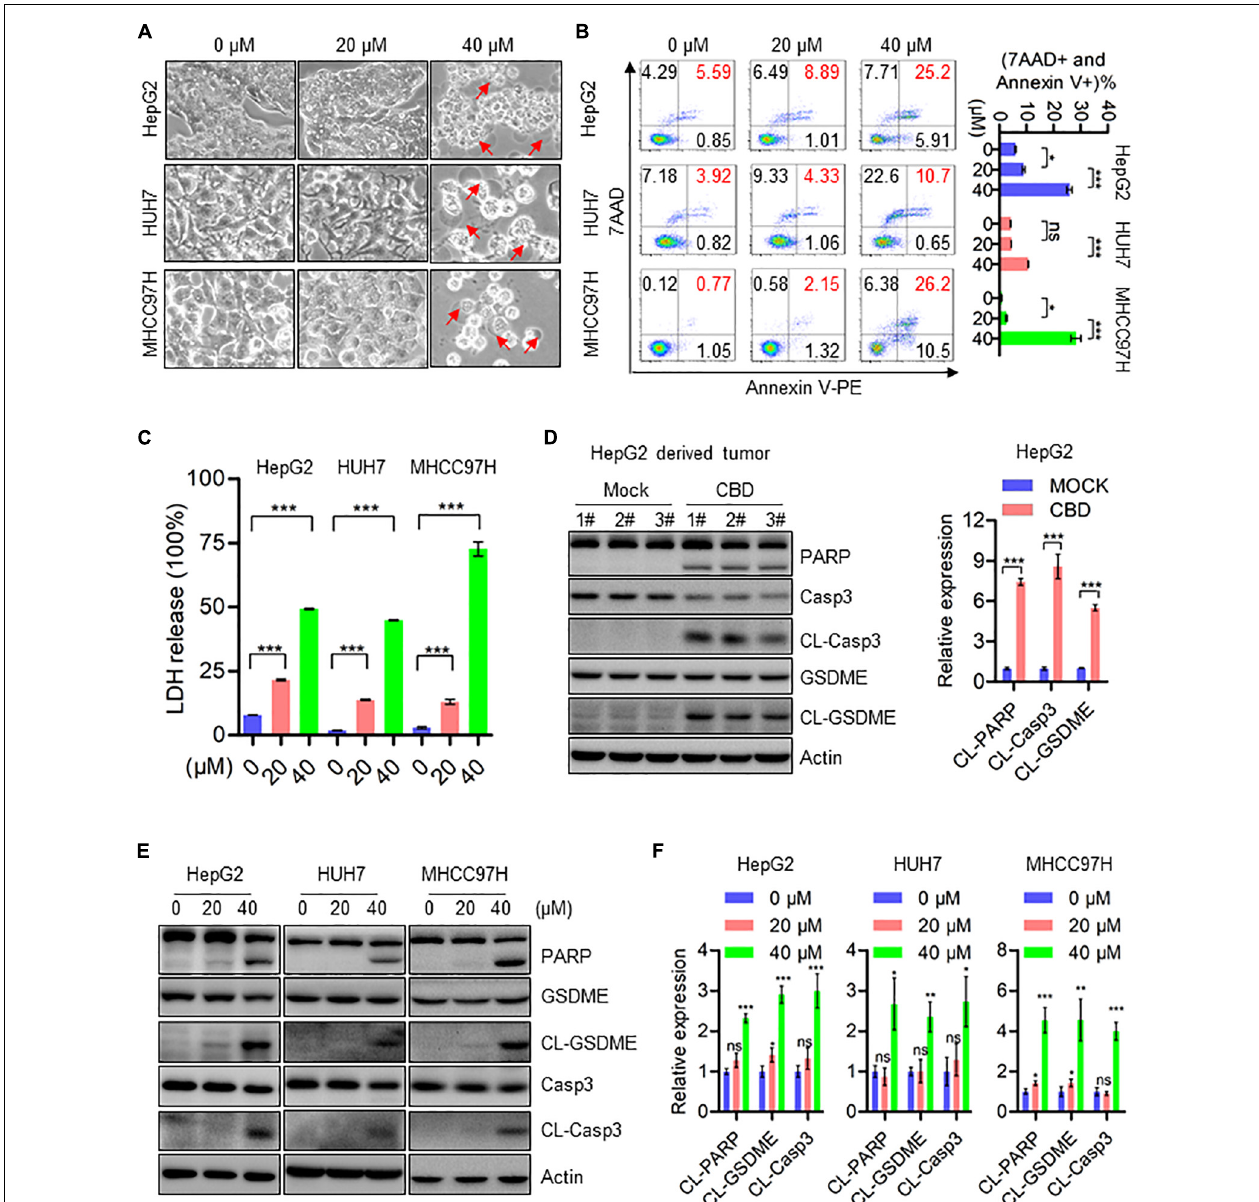
FIGURE 2 | CBD induces cell pyroptosis in HCC cells. (A) Representative morphological changes of HepG2, HUH7, and MHCC97H cells in response to different concentrations of CBD. (B) Flow cytometry analysis of cell apoptosis after the HepG2, HUH7, and MHCC97H cells treated with different concentration of CBD for 24 h. Cells were collected and stained with Annexin V-PE/7AAD. Data are presented as mean ± SD. (C) LDH release assays were performed on CBD exposed HepG2, HUH7, and MHCC97H cells for 24 h. (D) Western blot analysis of PARP, Caspase-3, CL-Caspase-3, GSDME, and CL-GSDME in CBD treated tumor tissues derived from HepG2 cells. Actin was used as a loading control. The graphs represent the mean ± SEM. (E,F) Western blot analysis of PARP, Caspase-3, CL-Caspase-3, GSDME, and CL-GSDME in CBD treated HepG2, HUH7, and MHCC97H cells after 24 h, and actin was used as a loading control. The graphs represent the mean ± SD. The meaning of ‘*‘ is statistically significant. * p < 0.05, ** p < 0.01, *** p < 0.001, n.s. represents no significance.